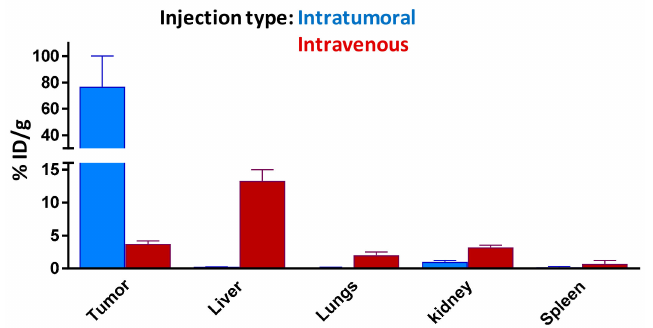
Figure 6. Comparison of tissue distribution of 67 Ga-AuNP-Gd-BBN in PC-3 xenograft Balb / c mice, 24 h after intratumoral and intravenous administration. All data are expressed as % ID / g (mean ± SD, n =